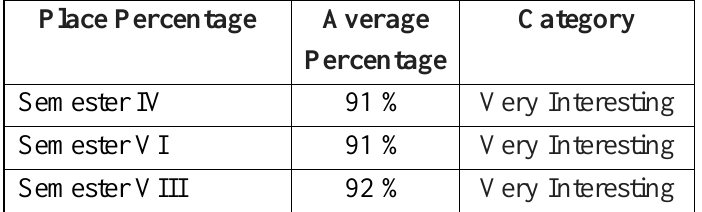
Table 2 Results of Media Squatted Media Questionnaire Analysis on Field